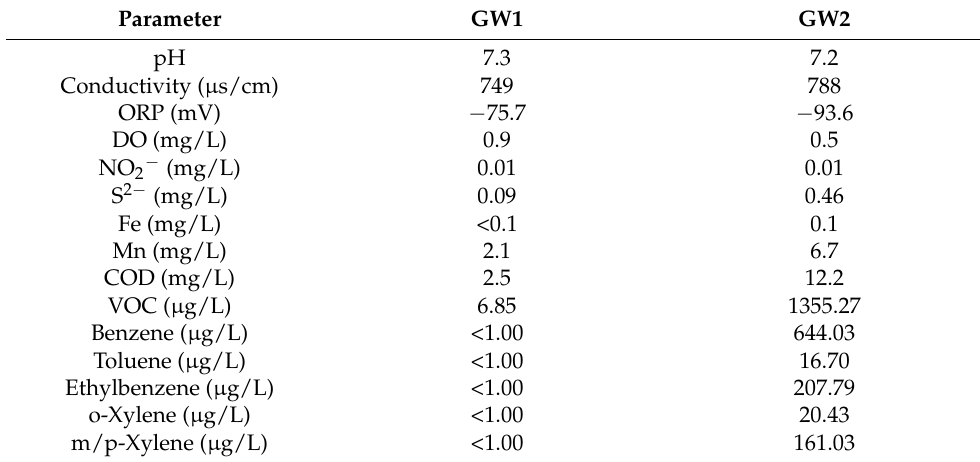
Table 2. Physicochemical properties of the groundwater samples.